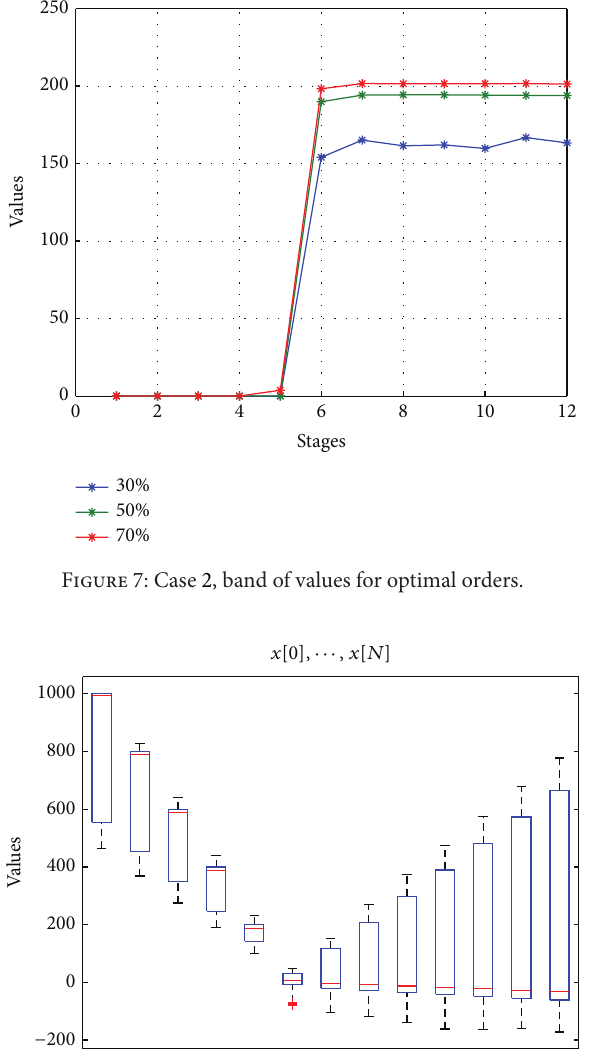
Figure 10: Case 2, Pareto front for a trade-off between the probabil- ities of having and not having